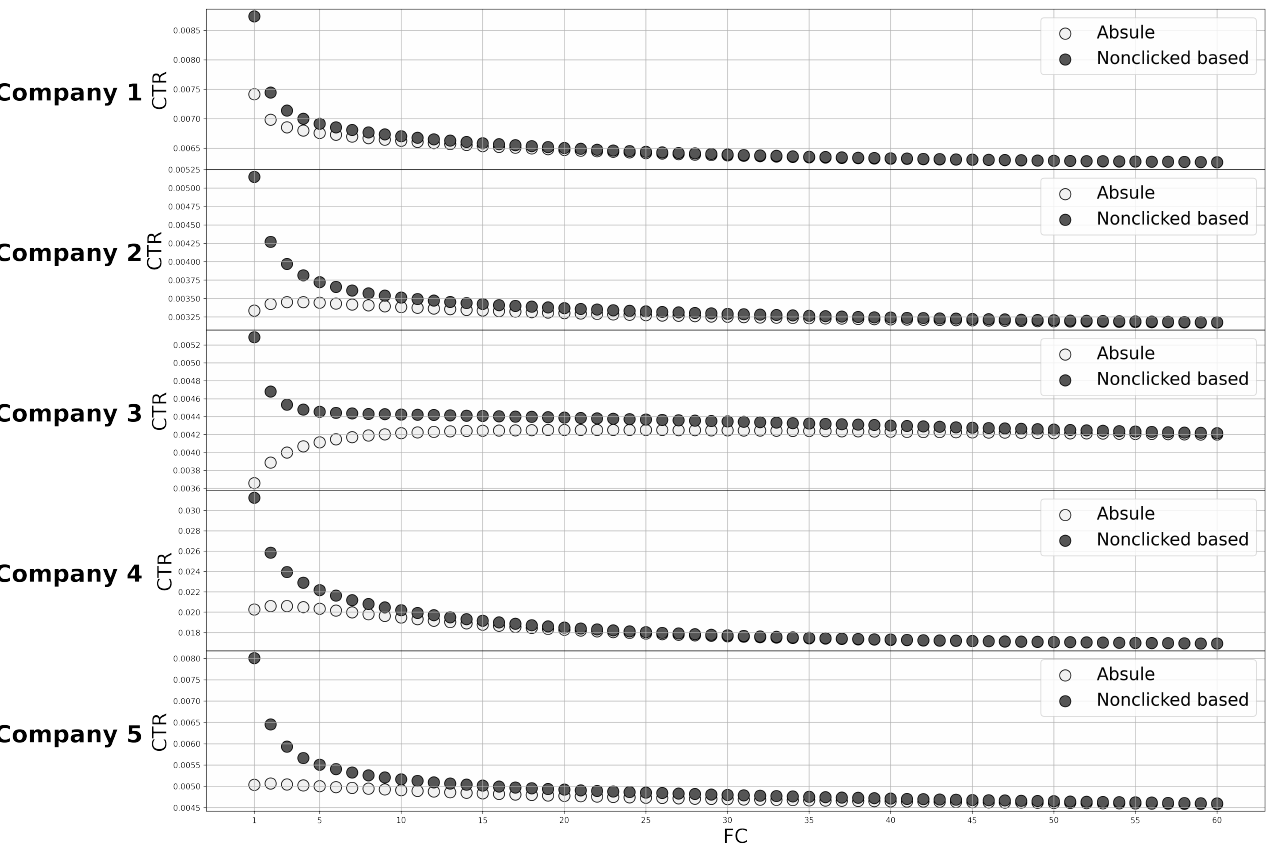
Figure 13. The figure shows us the CTR after applying different FC on the historical data for each of the companies. Figure 14 may again be a handy tool to select the FC value that leads to obtaining a minimum ROAS considered good by the client. The selected FC will guarantee the desired profitability while maximizing the revenue. If a advertiser decides to use a lower FC , it will obtain better profitability at the cost of reducing the revenue. ROAS is arguably the most important performance indicator when running a market- ing campaign as it measures profitability of the campaign. Therefore, this is the main focus for the executive level in any company trying to use digital marketing to sell products or services over the internet. Having this in mind, they will take care of ensuring profitability from the digital marketing campaign to ensure that the business is working correctly. To this objective, the method we have designed will help the managers decide on the number of impressions to show each user. This number will allow the activation teams to ensure that they are fulfilling the profitability target while maximizing the revenue. Furthermore, using the noble non-clicked strategies, even better performance can be achieved from the digital marketing